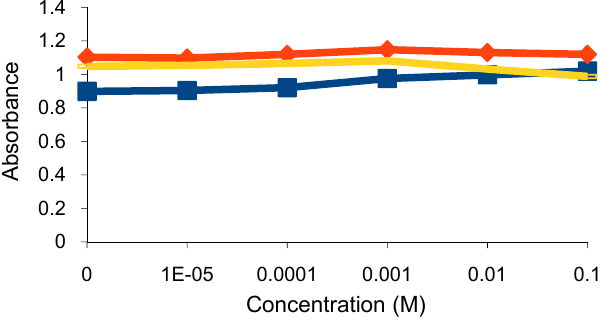
Figure 5. Variation of absorbance of sensing element vs. wavelength of different Hg 2+ ion